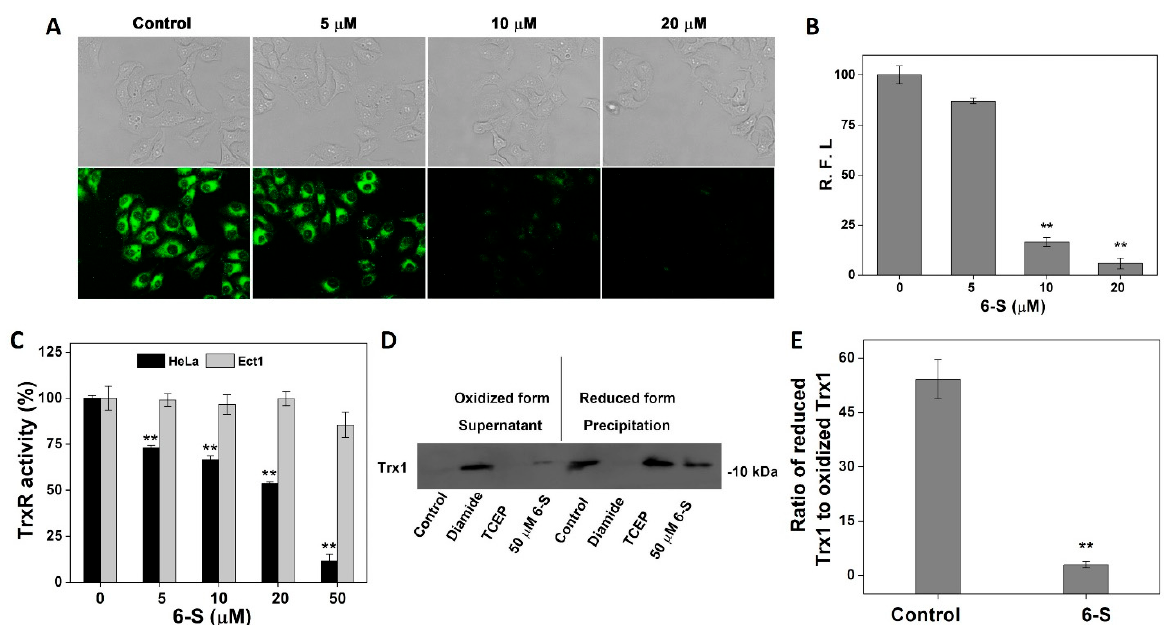
Figure 3. Influence of 6-S on Trx system. ( A ) Detection of TrxR activity using TRFS-green in HeLa cells. The phase-contrast (top panel) and fluorescence (bottom panel) microscopy images were captured using an inverted fluorescence microscope. Scale bars: 20 μ m. ( B ) Quantification of R.F.I. in individual cells by ImageJ. ( C ) Inhibition of TrxR activity in HeLa cells and Etc1 cells. After the cells were treated with the indicated concentrations of 6-S for 24 h, the cellular TrxR activity was measured using the endpoint insulin reduction assay. ( D ) Determination of the Trx redox state. HeLa cells were treated with vehicle or 6-S (0 μ M or 50 μ M) for 24 h, and the Trx1 redox states were measured. O: oxidized form, R: reduced form, S: Supernatant, P: Precipitation. ( E ) Quantitative analysis based on the ratio of reduced Trx1 to oxidized Trx1 by measuring the band density using IPP. Data are expressed as the mean ± standard error from three experiments. **, p < 0.01 vs. the control group.